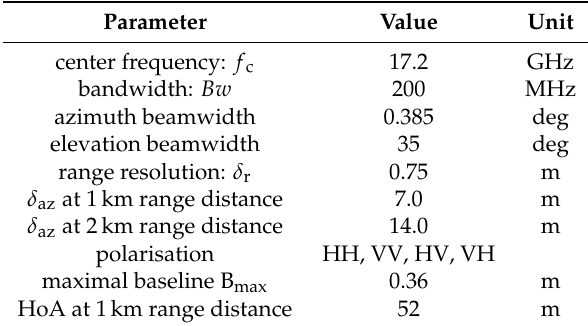
Table 1. Ku-band Advanced Polarimetric Radar Interferometer system parameters. Parameter Value Unit center frequency: f c 17.2 GHz bandwidth: Bw 200 MHz azimuth beamwidth 0.385 deg elevation beamwidth 35 deg range resolution: δ r 0.75 m δ az at 1km range distance 7.0 m δ az at 2km range distance 14.0 m polarisation HH, VV, HV, VH maximal baseline B max